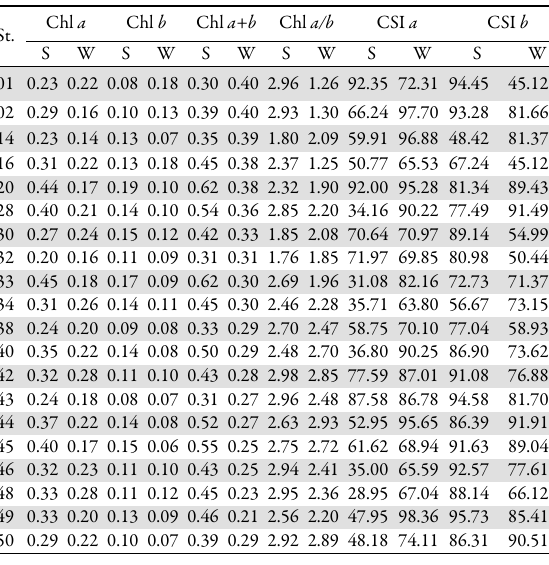
Table 4. Chlorophyll (Chl a , Chl b and Chl a+b ) concentrations (mg g-1 Table 5. Statistical analysis for the inorganic components (anions and cations) of Zilla spinosa and Leptadenia pyrotechnica plants, showing analysis f.wt.), chlorophyll a/b ratio (Chl a / b ratio) and chlorophyll stability index of variance (F-value) and determination coefficient ( ɳ 2 ) (CSI, %) at different stands inhabited by Leptadeina pyrotechnica plants, in summer and winter seasons Plant species Zilla spinosa Leptadenia CSI a CSI b St.